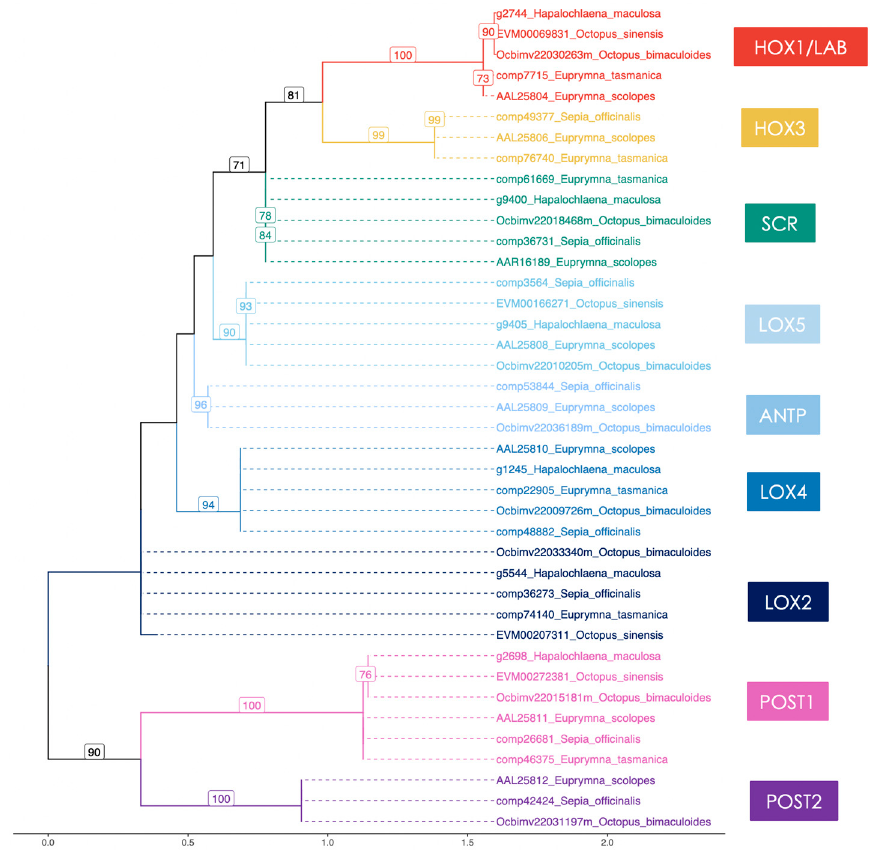
Figure 3. Maximum likelihood phylogeny of the HOX genes (aa) in six cephalopods. Bootstrap values >70 present on branches. Taxa are coloured in accordance with HOX genes.